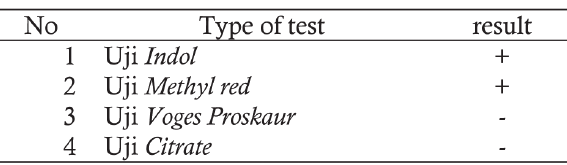
Figure 1. Schematic flow of treatment A, B, C, D,